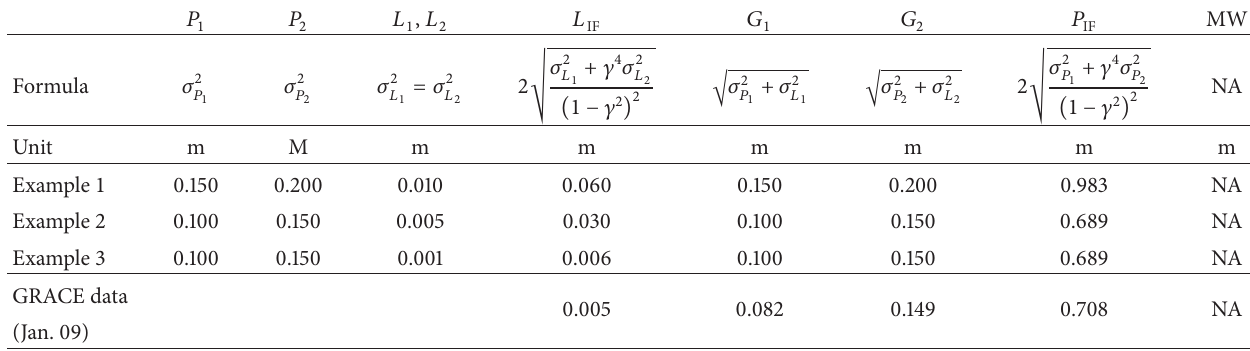
Table 1: Expected and estimated standard deviations of the various combinations for 𝜌 𝑗𝑘 estimation (NA: not available).